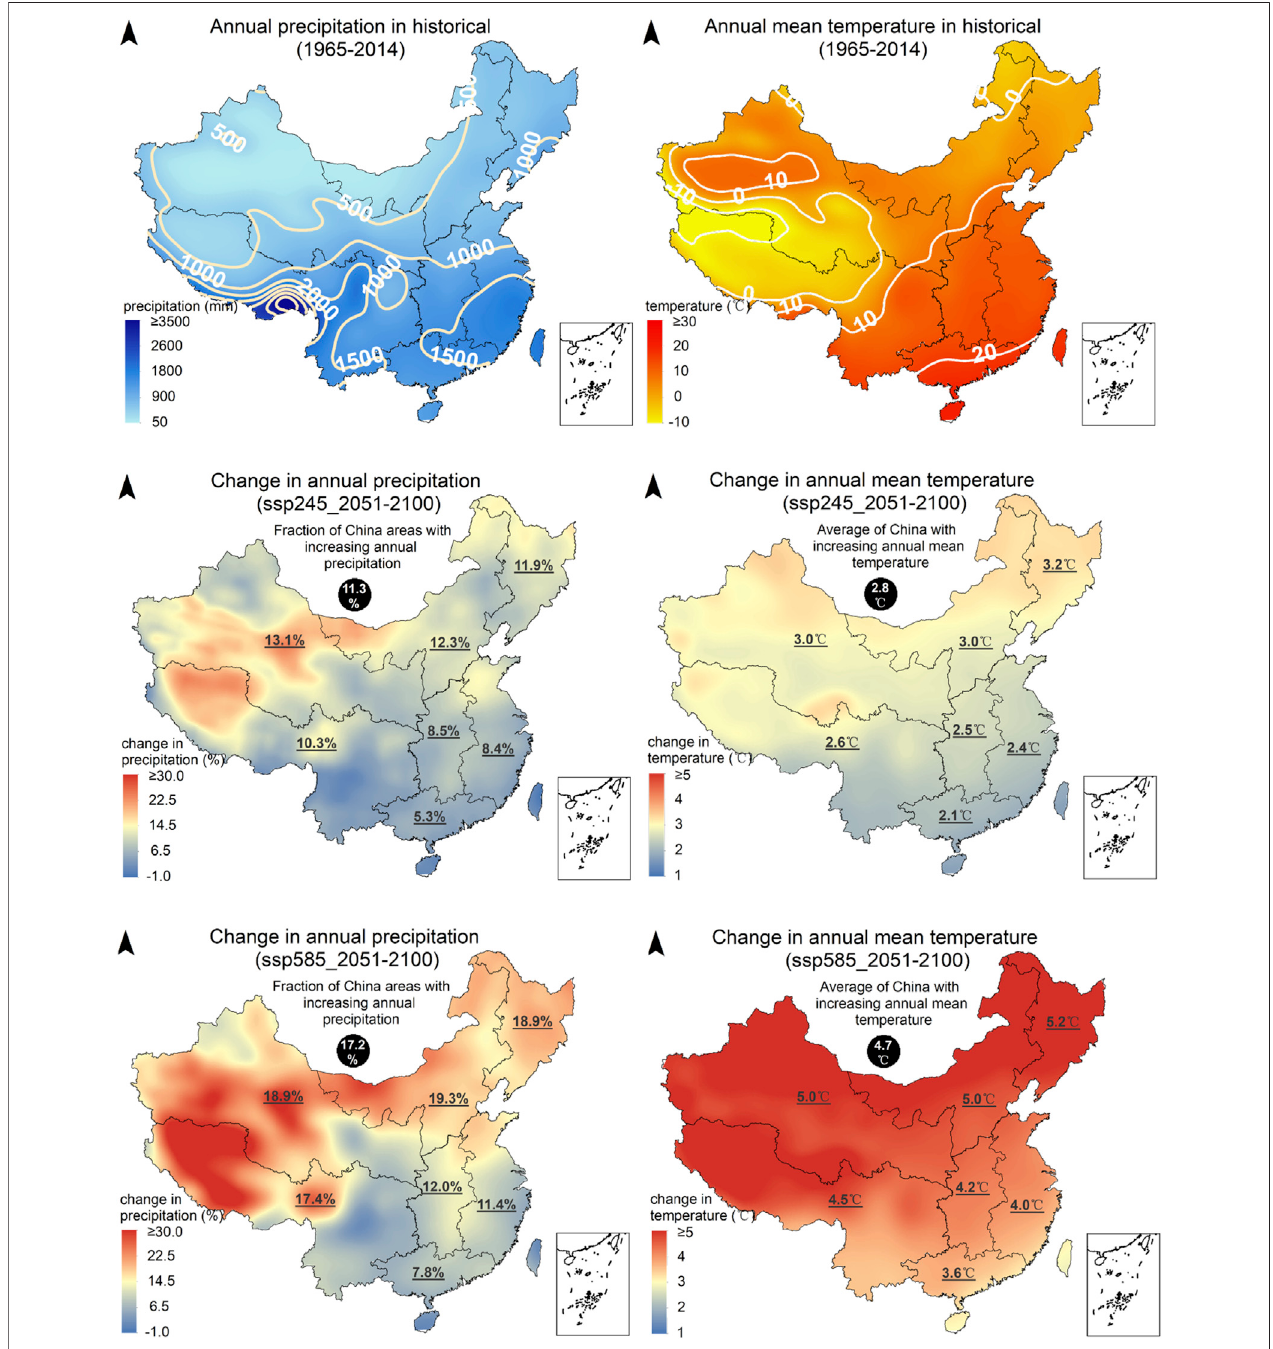
FIGURE 4 | The change in spatial distribution of annual precipitation and annual mean temperature during 2051 – 2100 under two SSPs relative to the historical period.